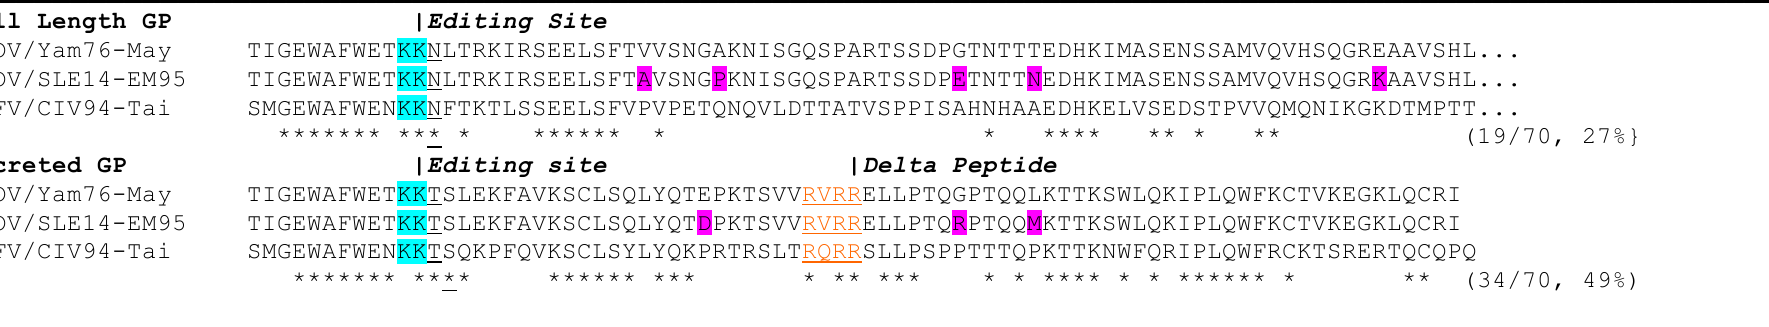
Table 1. Differential conservation in the Full Length Ebola virus glycoprotein versus the secreted glycoprotein after the RNA Editing Site